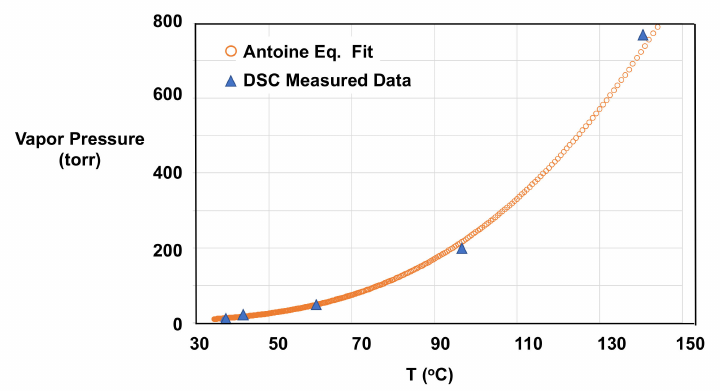
Figure 1. TSCH vapor pressure data acquired from DSC measurements. The experimental data were fitted to an Antoine Equation over the range of 0.14 to 760 torr.